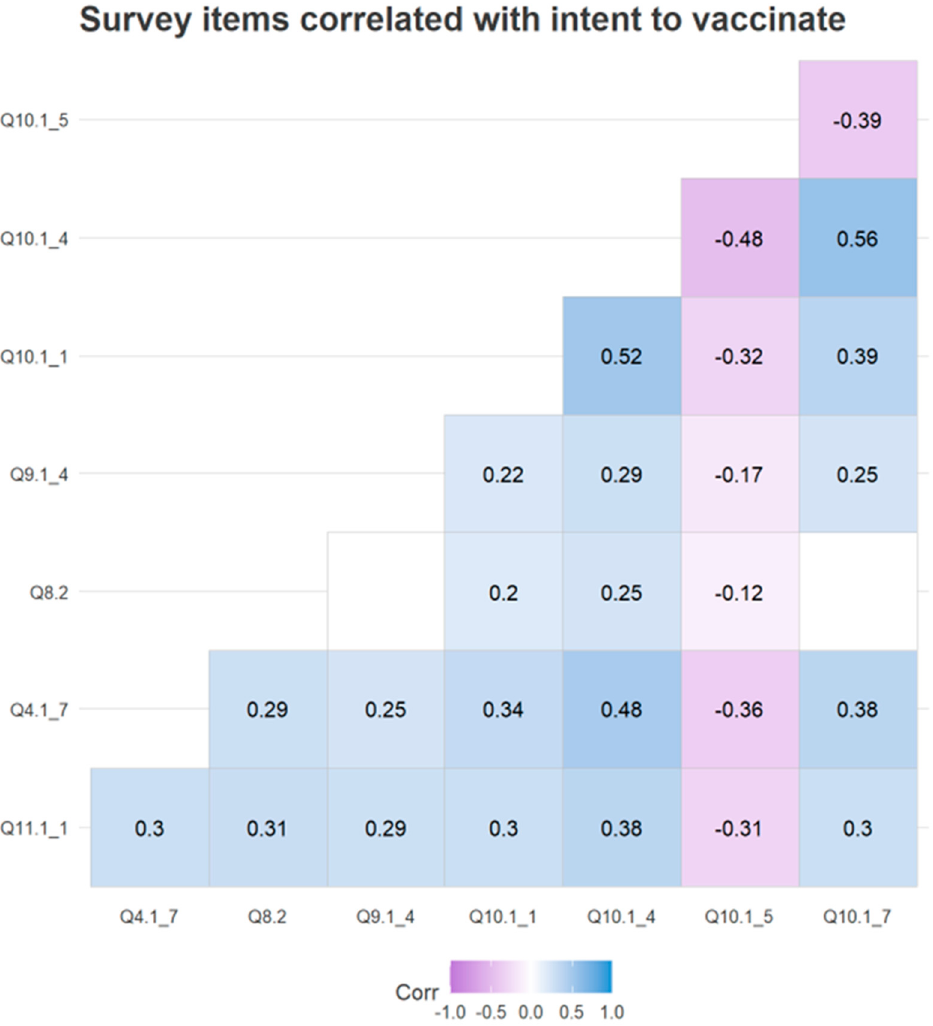
Figure 7. Survey items correlated with intent to vaccinate: A correlation matrix of the complete survey was created. Non-significant results and results with a low degree of correlation were removed to create an abbreviated correlation matrix. Blue coloration indicates a positive correlation with question 11.1.1 “I intend to vaccinate my children against HPV OR I have already vaccinated my children against HPV”, purple indicates a negative correlation, blank cells indicate that a result was not significant. Values are PCC correlation coefficients. Table 4. Survey items moderately or highly individually correlated with intent to vaccinate.